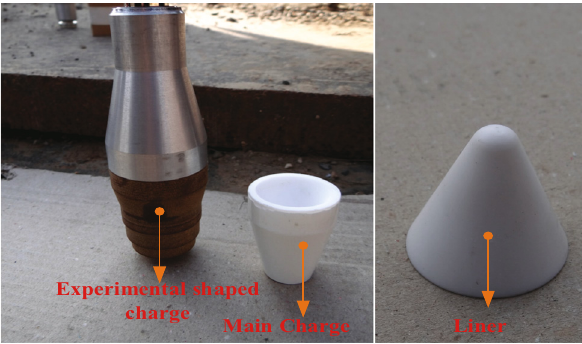
Figure 1: Photograph of the shaped charge with a diameter of 40